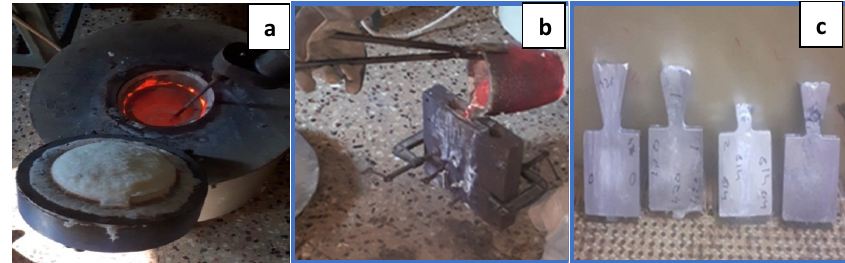
Figure 1. ( a ) Stir casting set-up; ( b ) pouring into die; ( c ) composite specimen.